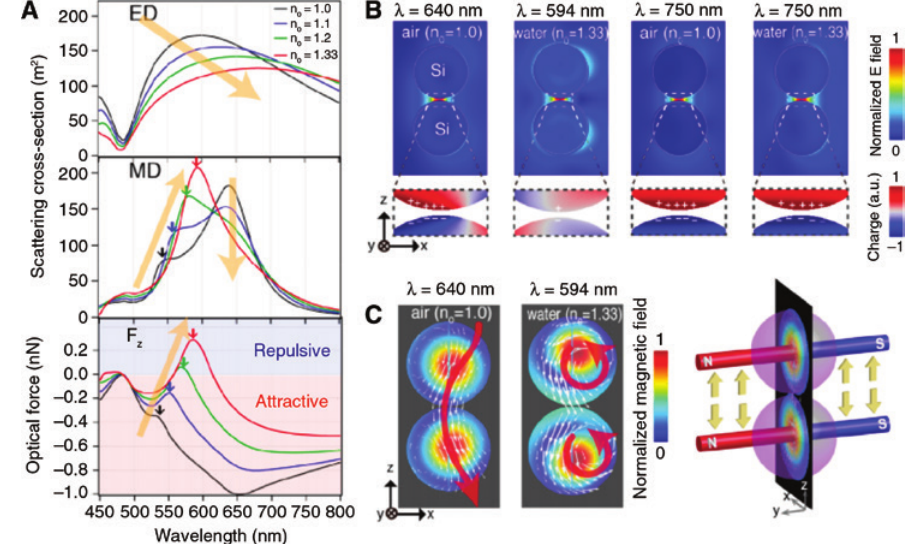
Figure 9: Magnetic optical binding forces. (A) Scattering spectra of the electric dipole (ED) and magnetic dipole (MD) modes and optical binding force of the Si nanodimer calculated for surrounding refractive index (n ) increase from 1.0 to 1.33. (B) Electric field distribution and surface charge density at different wavelengths in 0 air and water. (C) Left, magnetic field distribution and current flow at 640 nm and 594 nm. Right, schematic representation of the repulsive